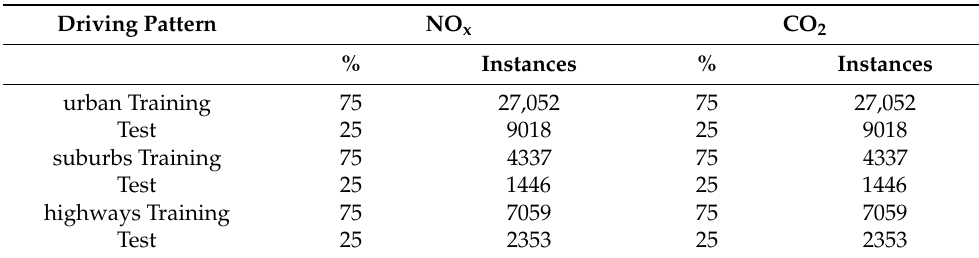
Table 5. Training and test